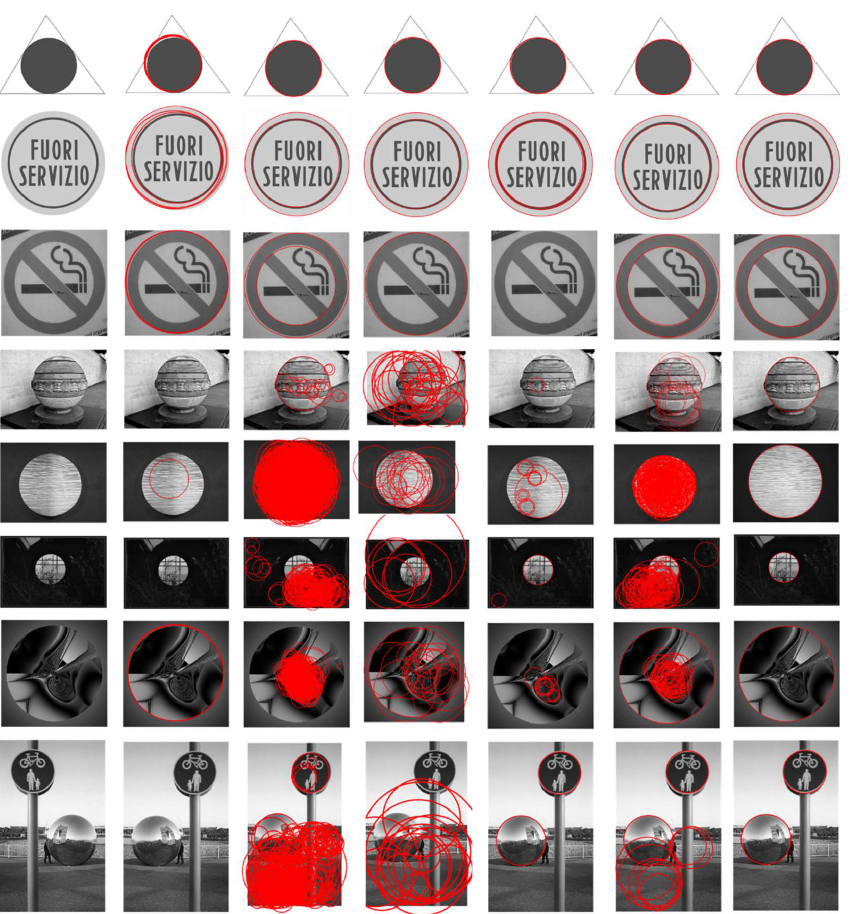
Figure 8. Circle detection results on the dataset GH, which is widely used by other algorithms. From the left to right columns: input image, RHT, RCD, CACD, Jiang, Wang and ours. As can be seen, the proposed method obtains better performance than the others.